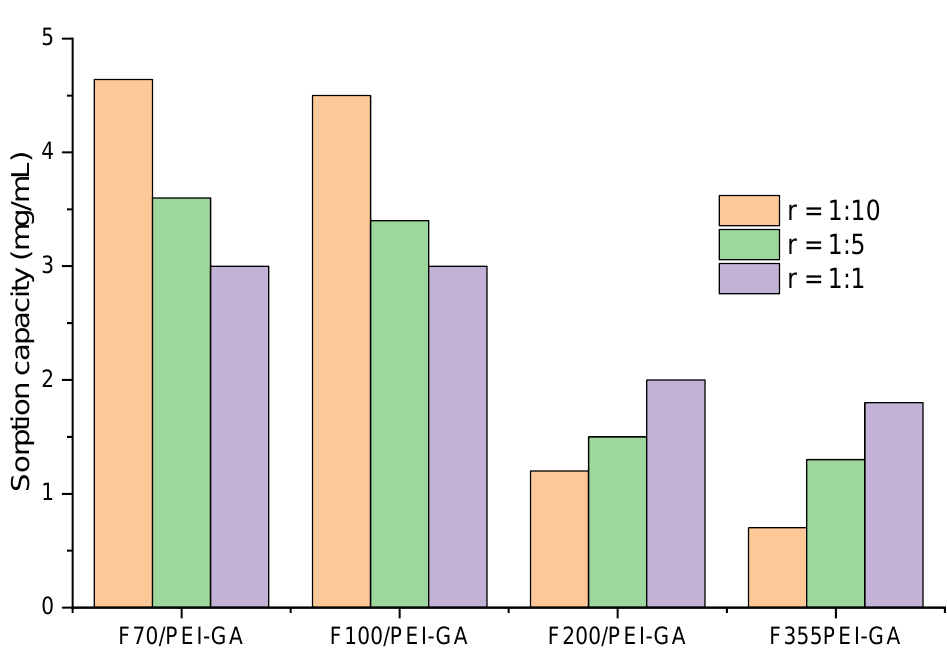
Figure 6. Maximum sorption capacity of the composite sand fractions evaluated in dynamic condi- tions in column (C Cu2+ = 100 mg/L, Flow = 2 mL/min) (continuous mode). The column experiments on Cu 2+ removal from aqueous solution (C i = 100 mg/L) are presented in Figure 7. Using a peristaltic pump, the aqueous solution was introduced with a flow of 2.0 mL/min in a column filled with 1.4 mL sorbent.